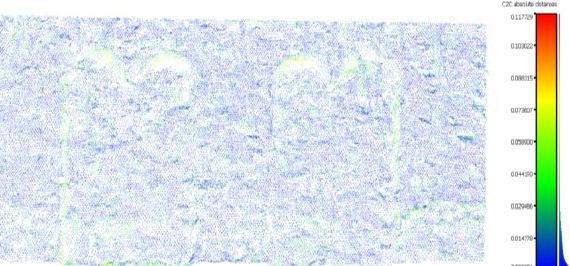
Figure 15. Discrepancies map between the TLS cloud and PhotoScan results.